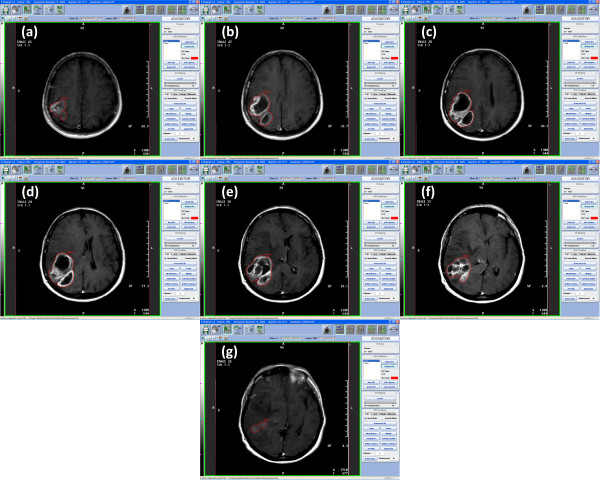
(a-g)-Example of contouring. Preoperative enhancing tumor in a glioblastoma patient.